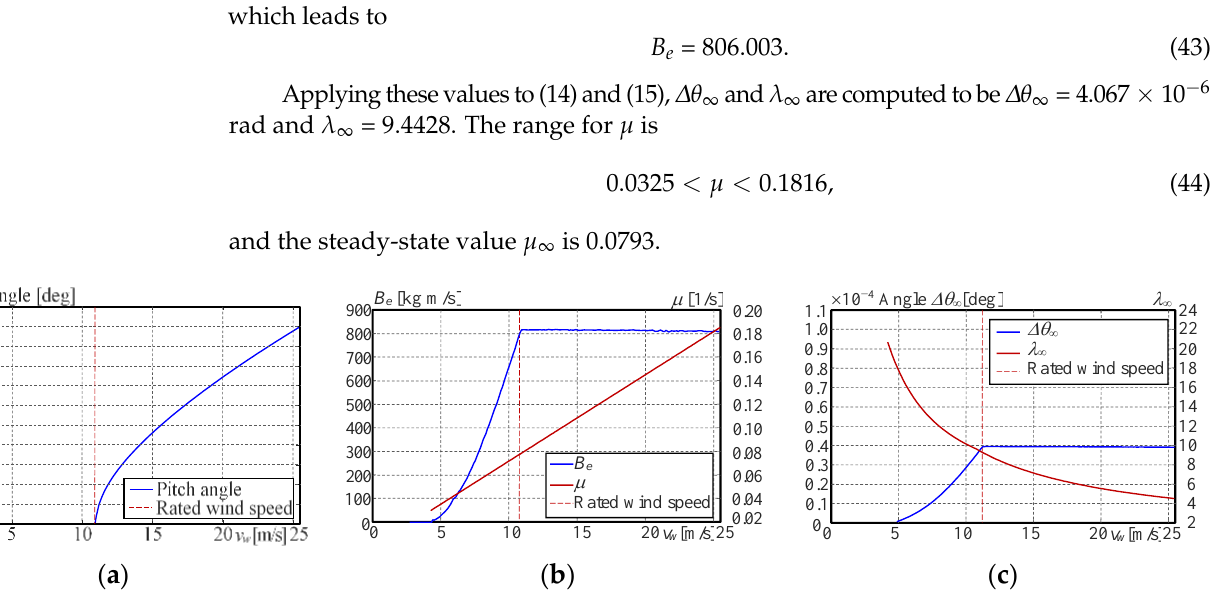
Figure 6. ( a ) Locus of pitch angles; ( b ) parameter B e and variable μ ; ( c ) steady-state twist angle Δθ ∞ , and tip-speed ratio λ ∞ . and tip-speed ratio λ ∞